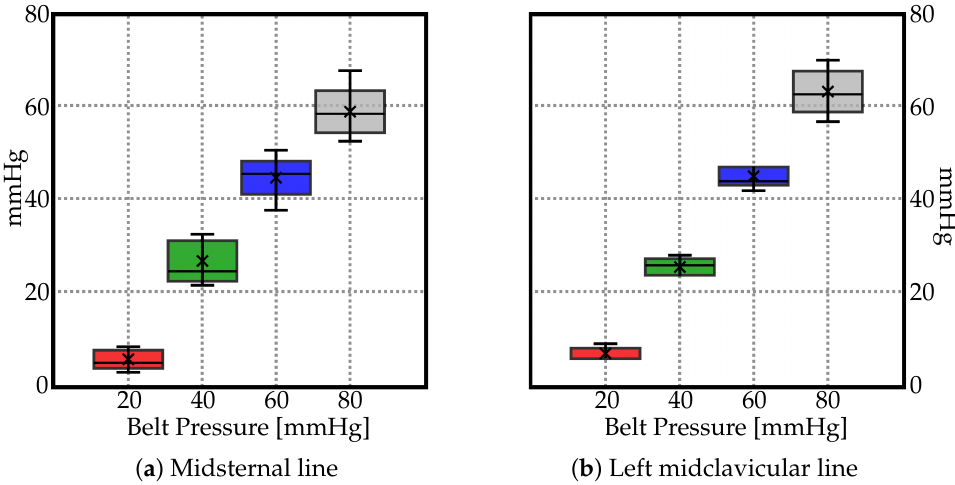
Figure 4. Box plots depicting groups of the data through their quartiles for ( a ) midsternal line, and ( b ) midcervical line. The ’ × ’ depicts the average